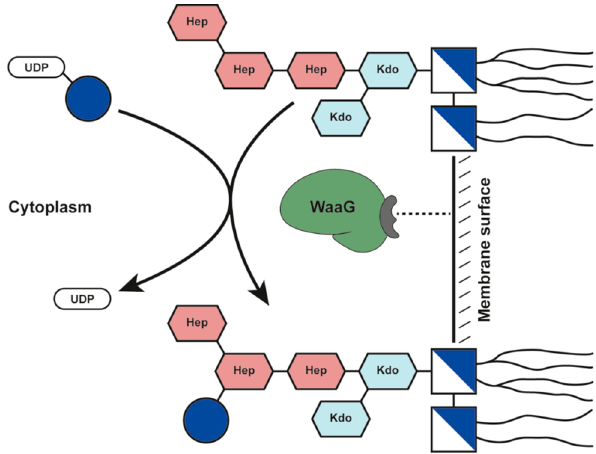
Figure 1. Schematic of the action of the glycosyltransferase WaaG transferring a D -glucose residue (blue ball) from UDP-glucose to heptose-II of the inner core of an LPS molecule.